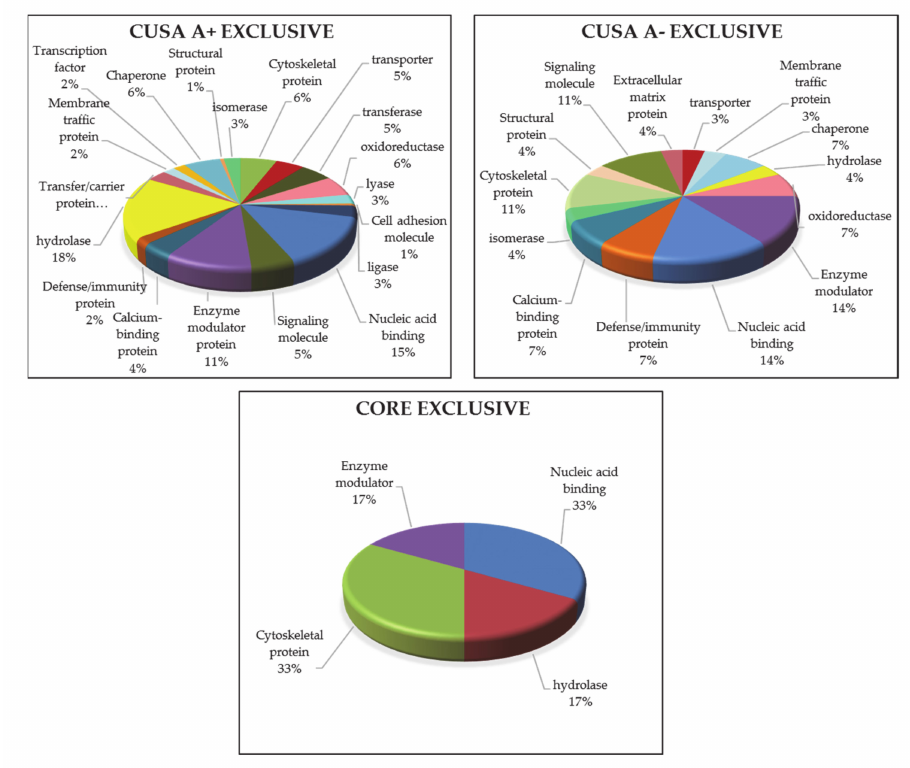
Figure 9. GO analysis of protein classes in each exclusive